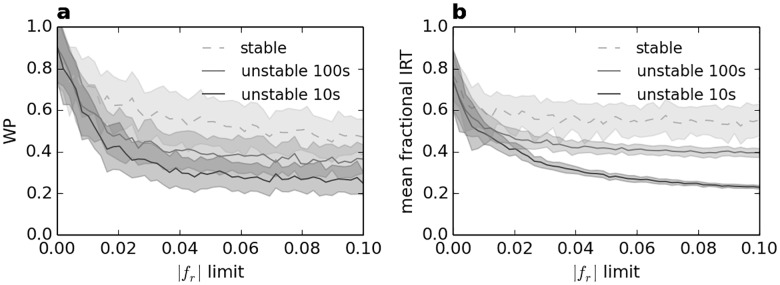
Effect of different magnitudes of fr range on WP and IRT for stable personality and unstable diversity.Ranges follow a uniform random distribution centred on 0 within the given |fr| limit. Unstable diversity changes the fr value of agents at regular intervals, as shown in the legend; changes are staggered randomly between agents. (a) WP versus personality range, (b) mean fractional IRT versus personality range.